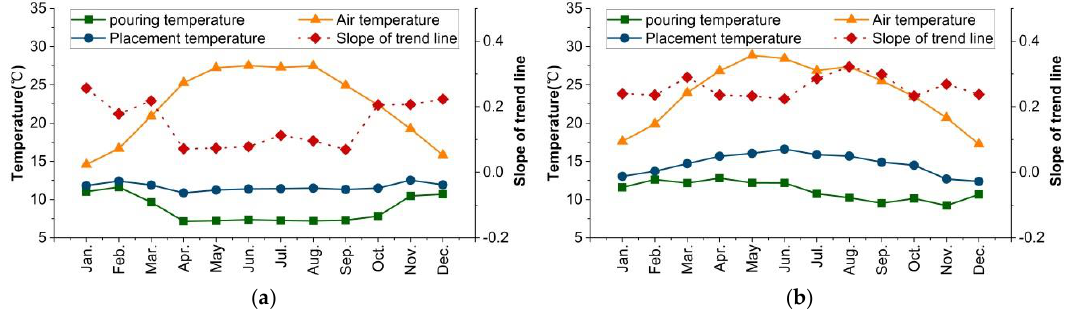
Figure 11. Monthly averages of the related data: ( a ) Baihetan dam; ( b ) Wudongde dam.